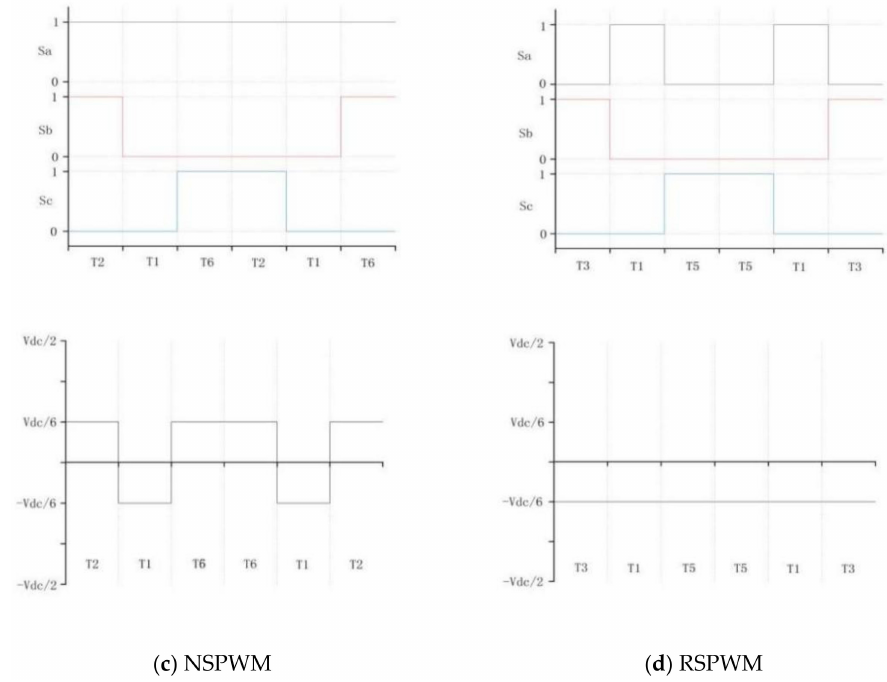
Figure 3. Synthesis and the corresponding CMV.